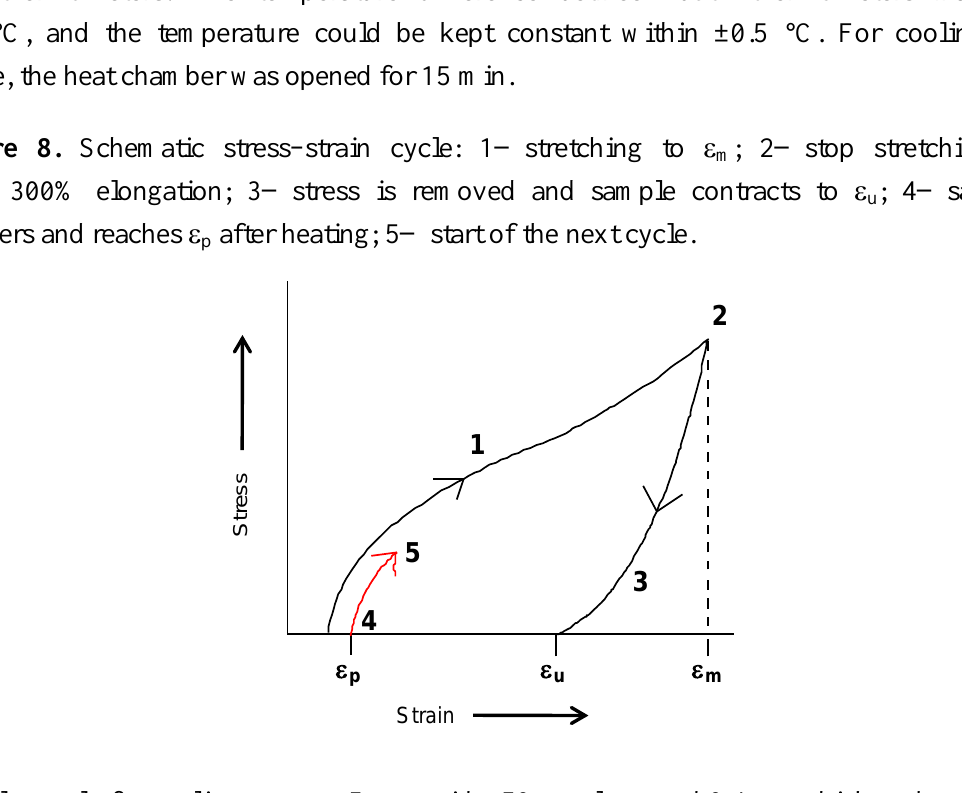
; 2—stop stretching at m ; 4—sample u